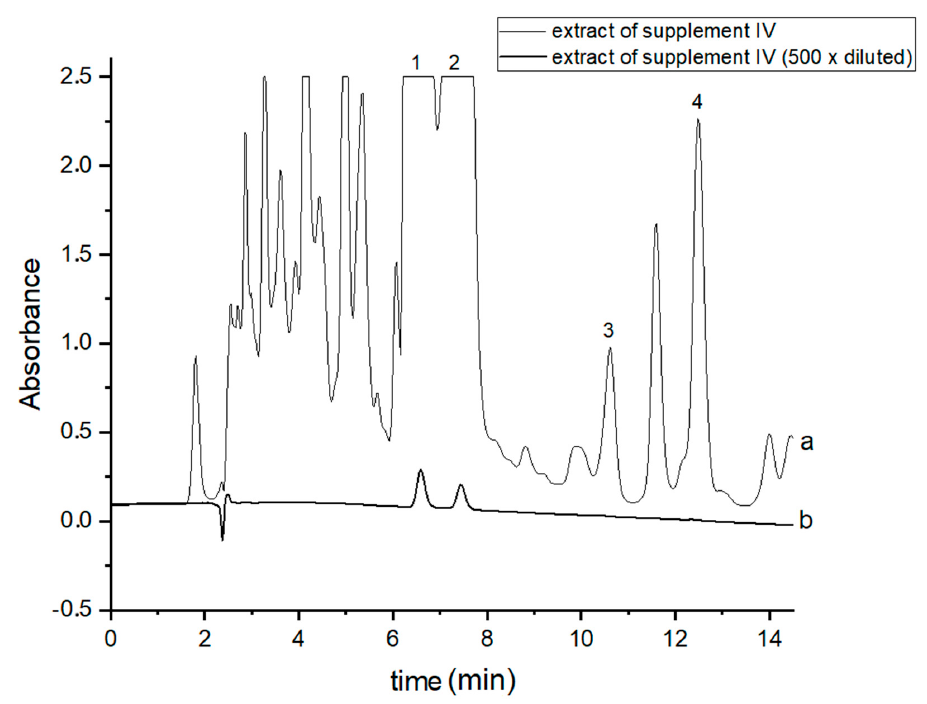
Figure 2. Chromatograms of the analyzed oil ‐ resin supplement IV ‐ (a) original extract and (b) 500 times diluted extract. The compounds were detected at λ = 220 nm. 1—CBDA, 2—CBD, 3—CBN and 4— Δ 9 ‐ THC.